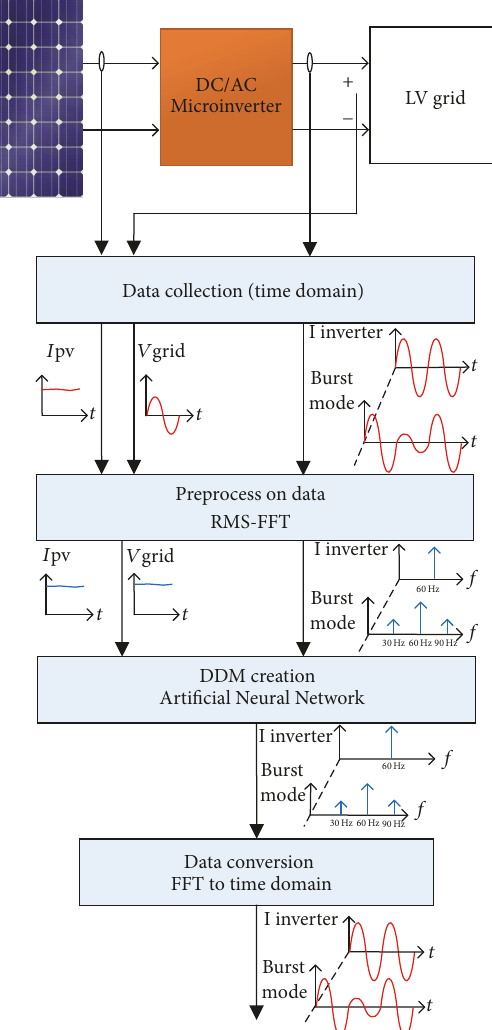
Figure 9: Workflow for proposed DDM approach.